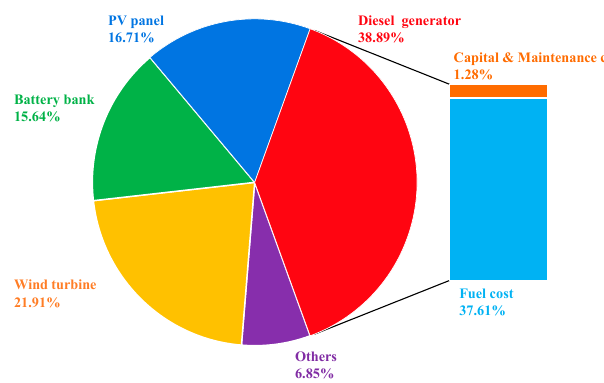
Figure 8. HES cost distribution for the best configuration.